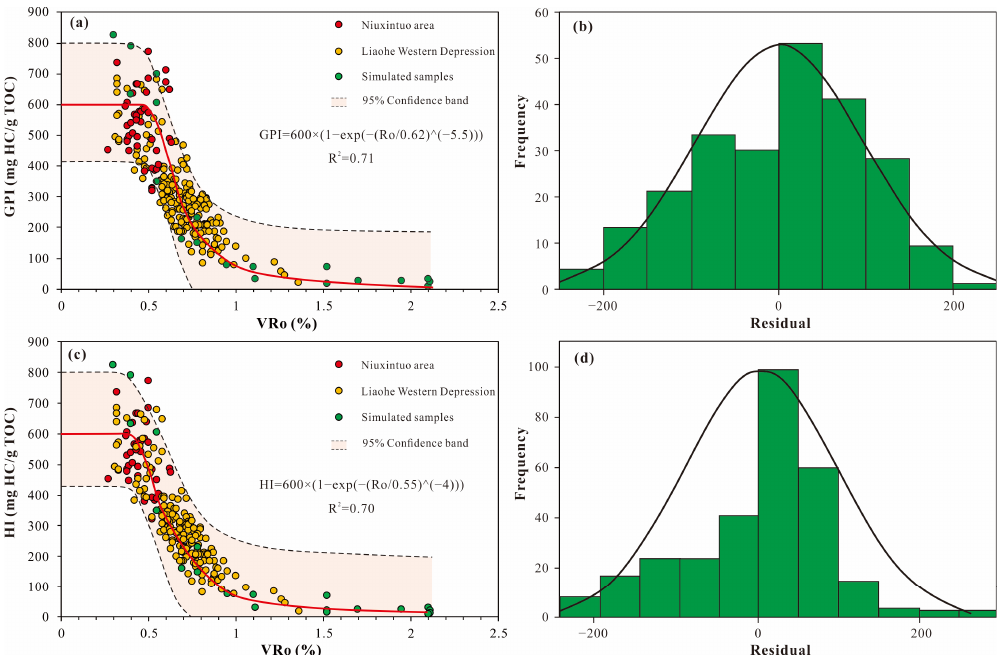
Figure 12. The fitted model of Rock ‐ Eval data and VRo using the data ‐ driven approach. ( a ) GPI vs. Ro. ( b ) Residual histogram of GPI ‐ Ro. ( c ) HI vs. Ro. ( d ) Residual histogram of HI ‐ Ro.